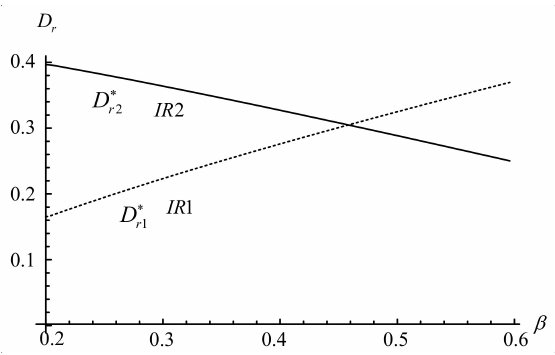
Figure 4. Impact of β on the IR’s demands.